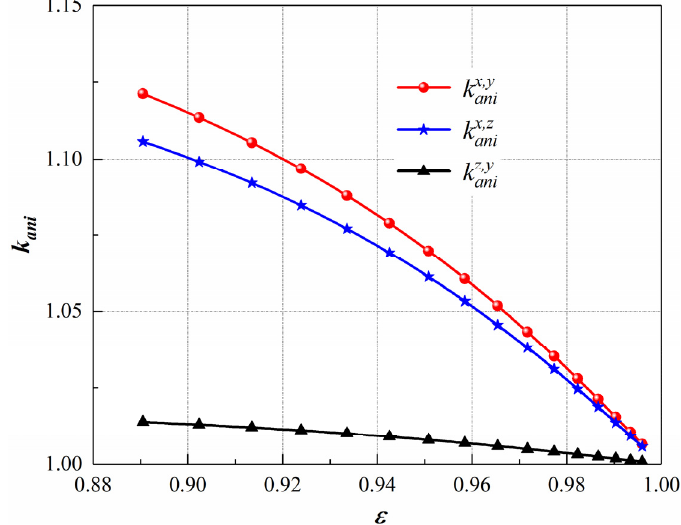
Figure 10. The variations of K ani with ε in different directions at k r = 10.